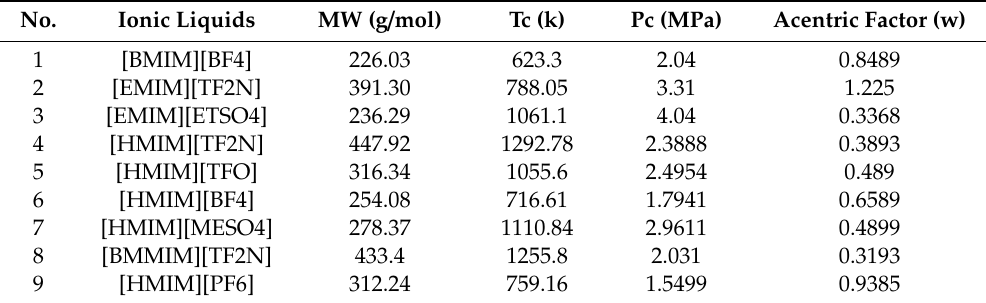
Table 1. The properties of ionic liquids (ILs) in this study.